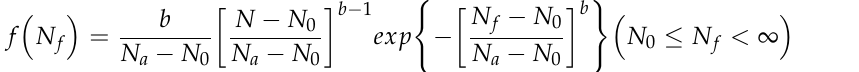
NC-SF0.5 ( c ) NC-SF1.0 and ( d )